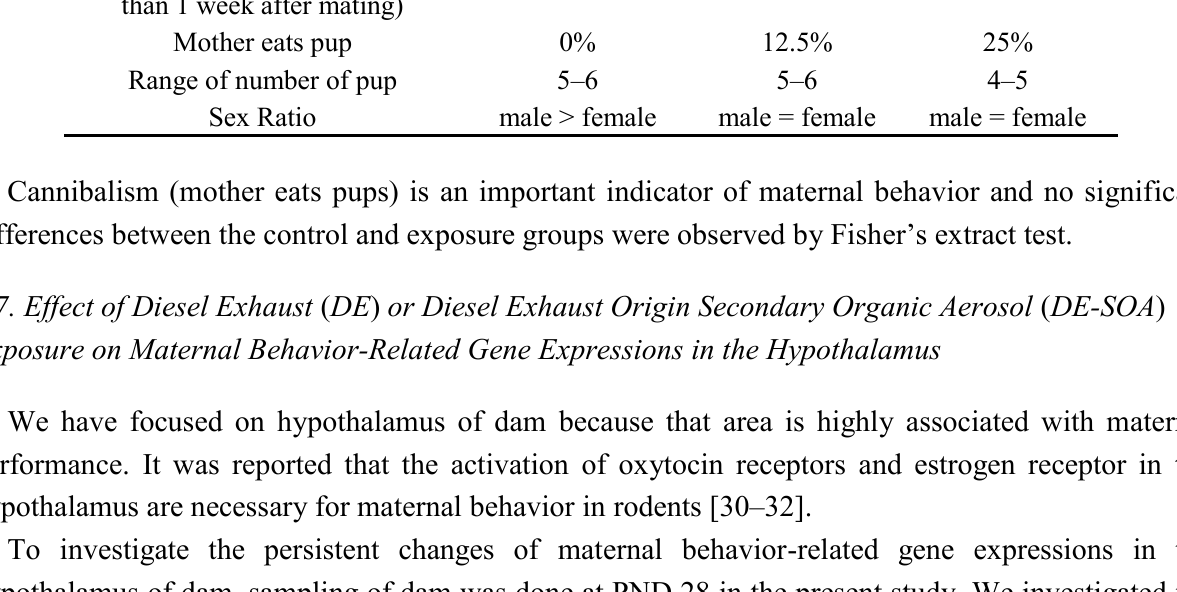
Data represent percentage of mice showing maternal behaviors ( n = 8).